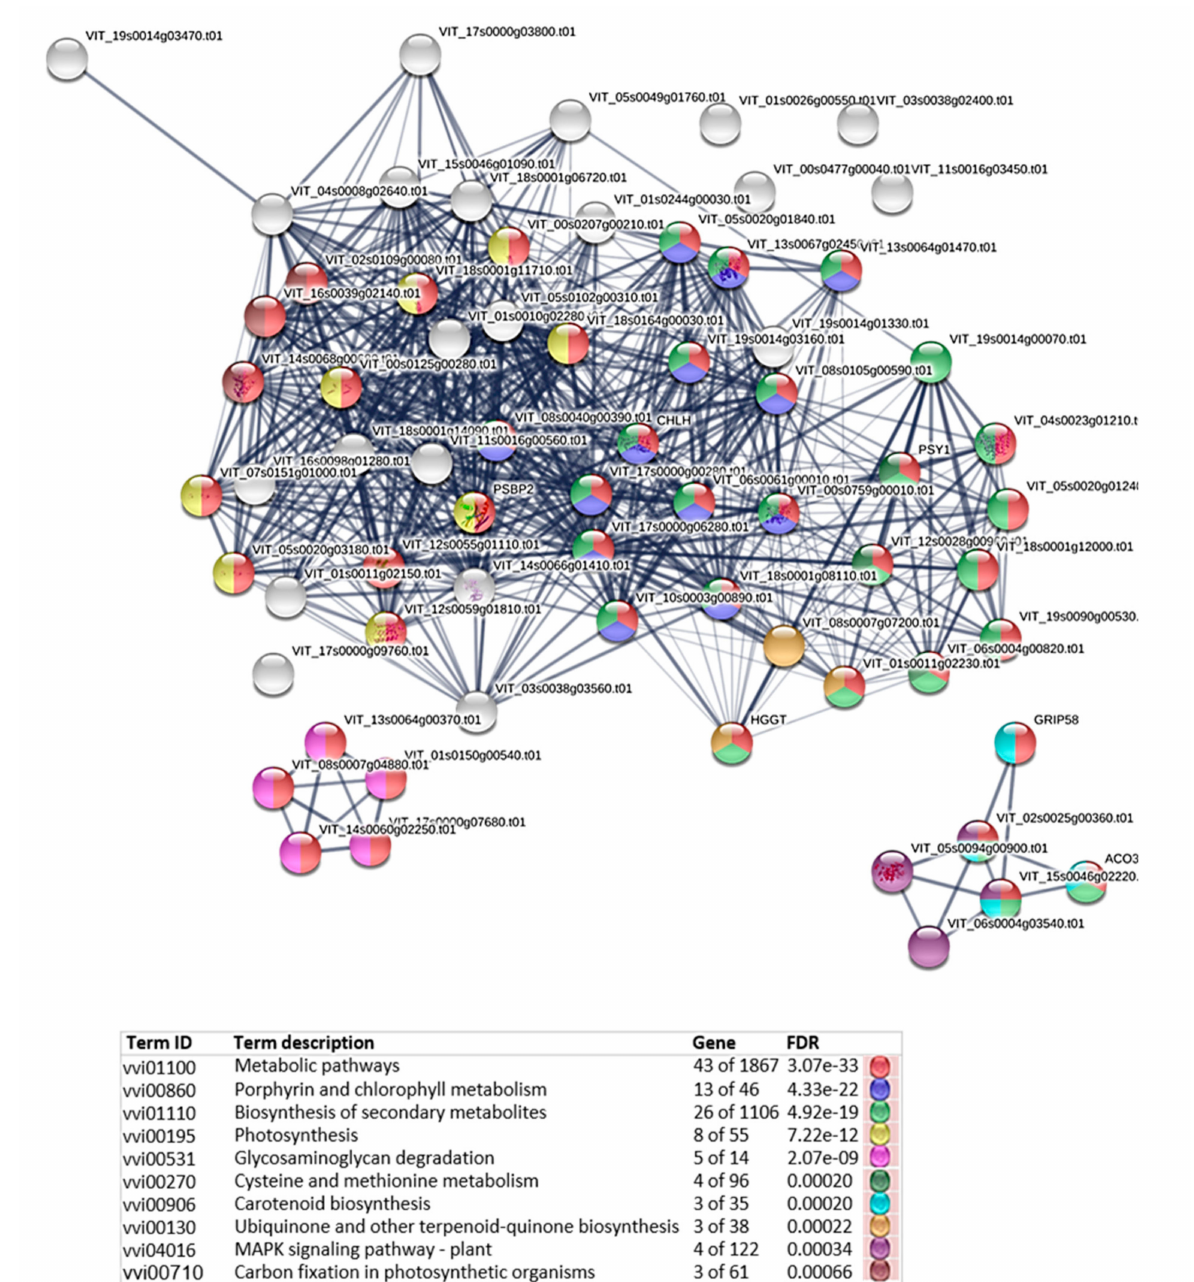
Figure 9. Protein–protein interaction network for fruit at 7 vs. 50